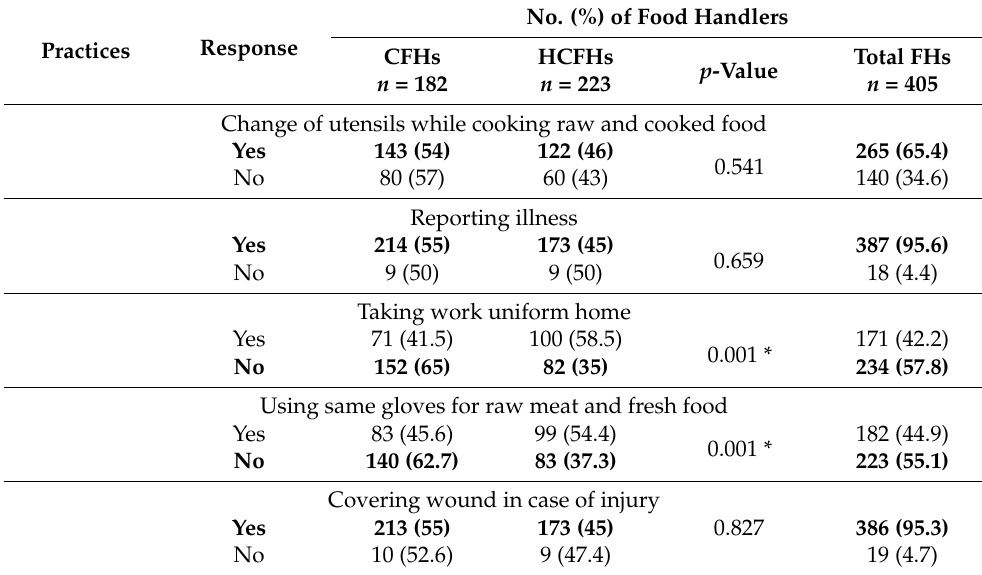
Table 6. Food safety and hygienic practices among healthcare and community food handlers.